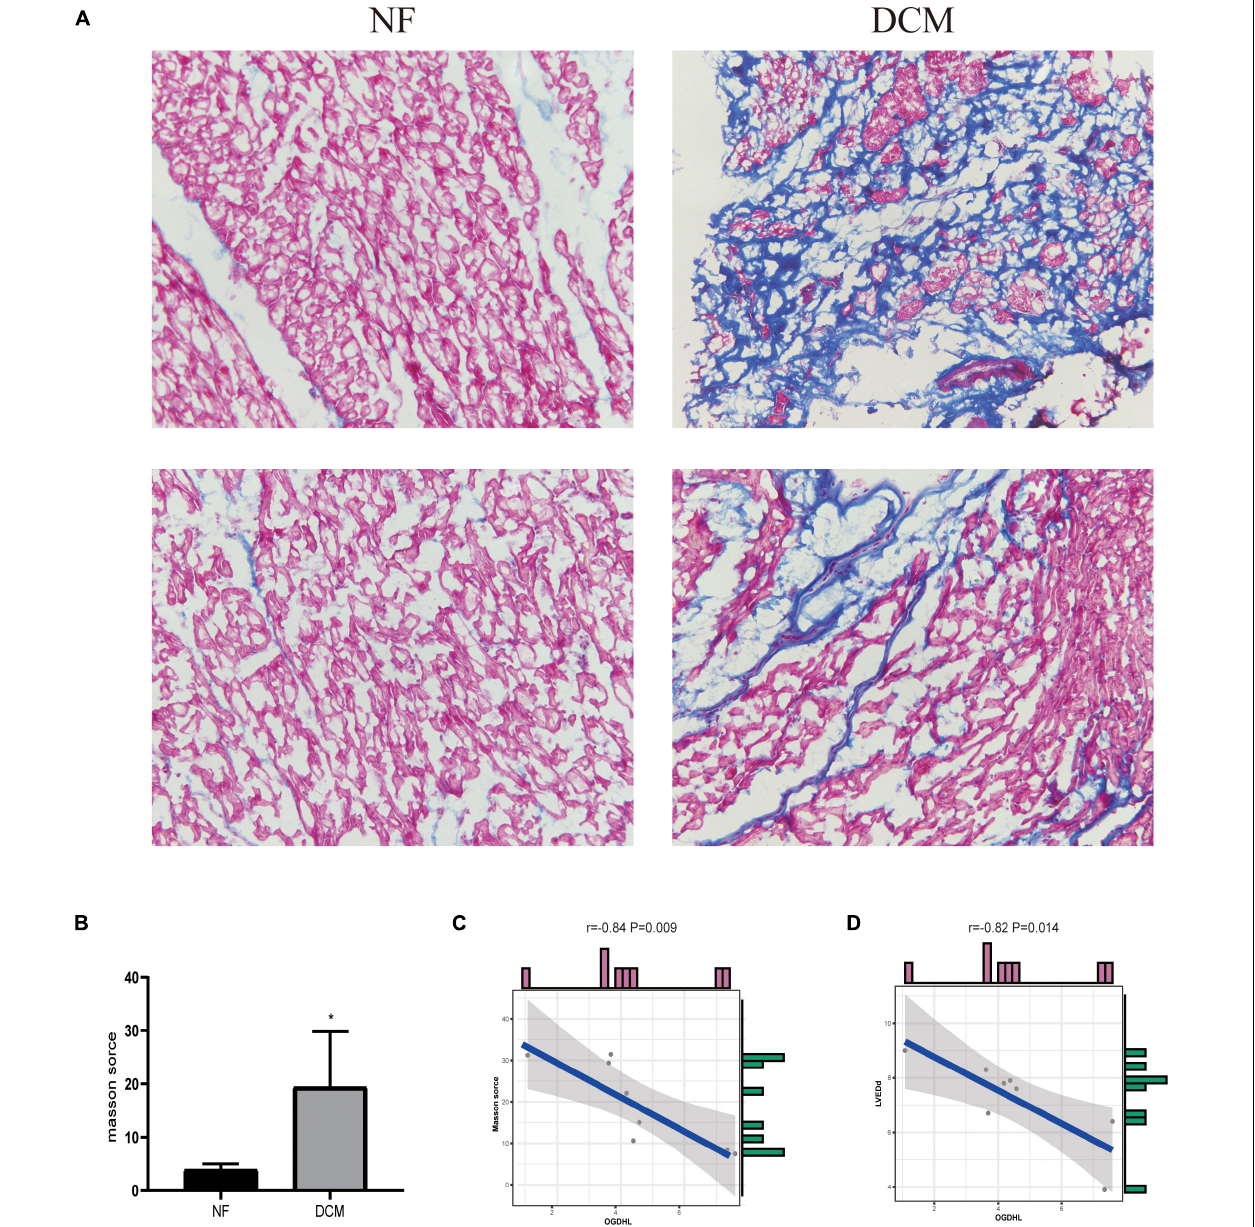
FIGURE 6 | OGDHL expression is negatively correlated with heart fibrosis in patients with DCM. (A) Representative Masson’s stained images of heart sections from patients with DCM and NF donors (magnification 200 × ). (B) Masson’s staining scores of DCM group and NF group. (C) Correlation analysis between Masson’s score and OGDHL mRNA level. (D) Correlation analysis between OGDHL mRNA level and left ventricular end-diastolic diameter (LVEDd). * P < 0.05 vs. NF. n =